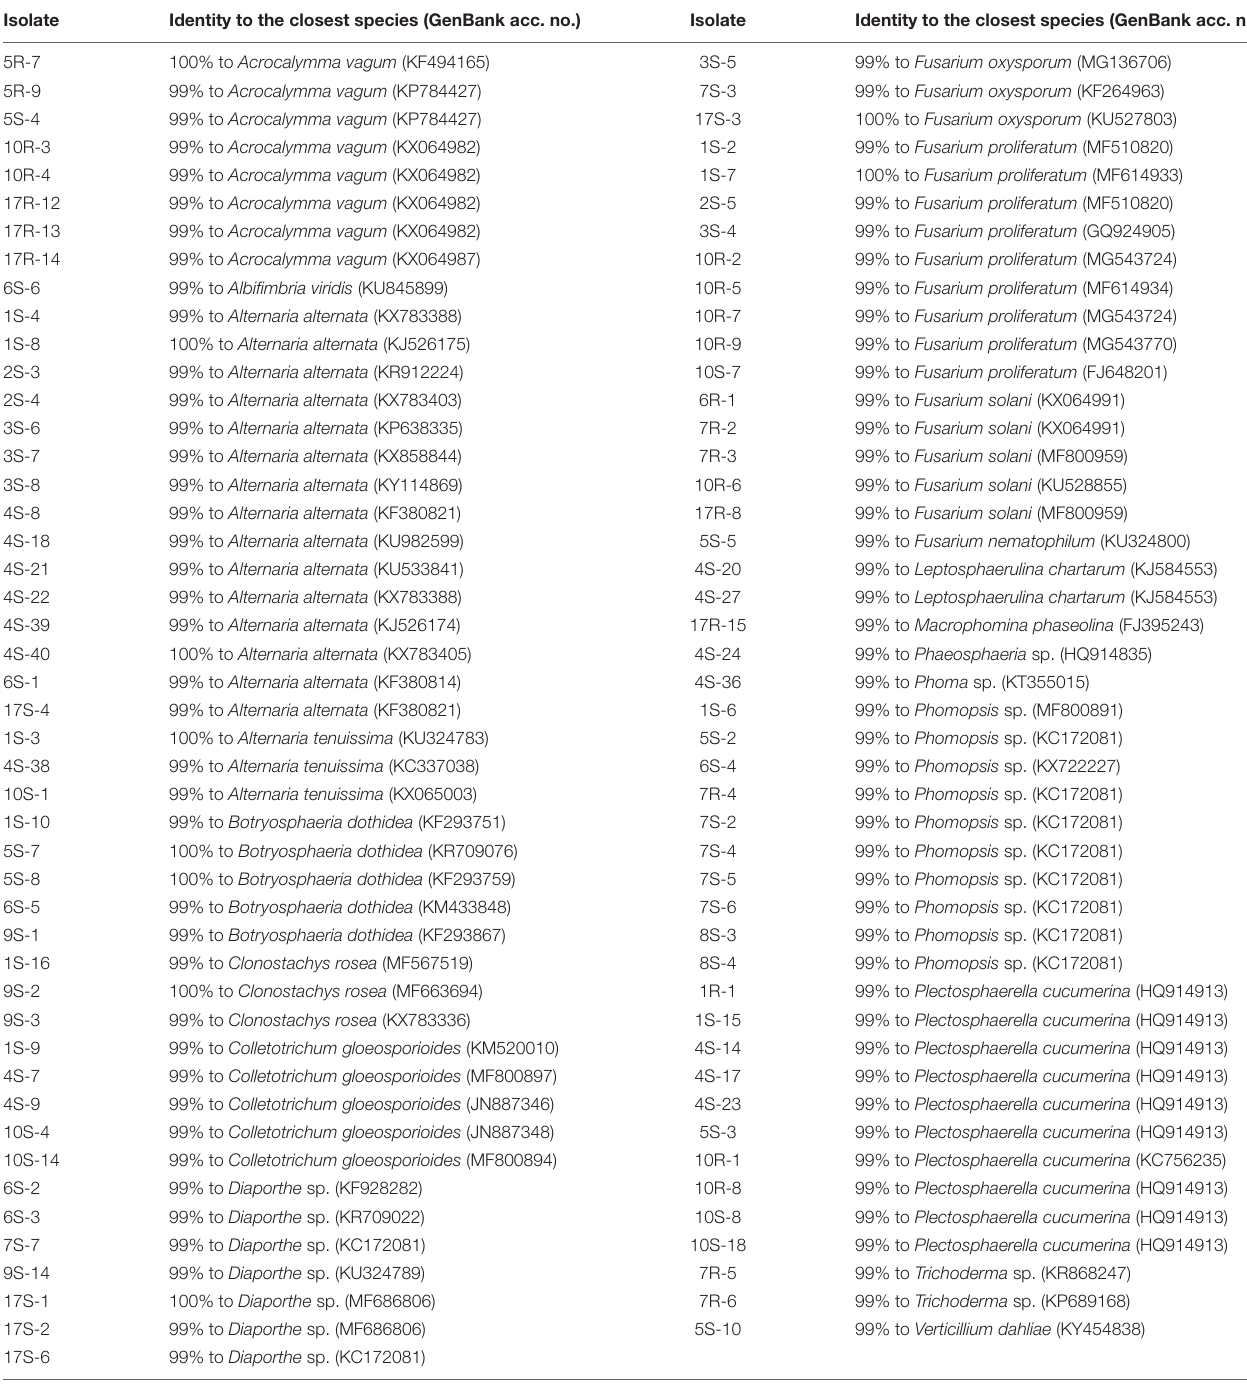
TABLE 1 | Identification of the endophytic fungi from cotton by analysis of the ITS (ITS1–5.8S rDNA–ITS2) sequences. Isolate Identity to the closest species (GenBank acc. no.) Isolate Identity to the closest species (GenBank acc.